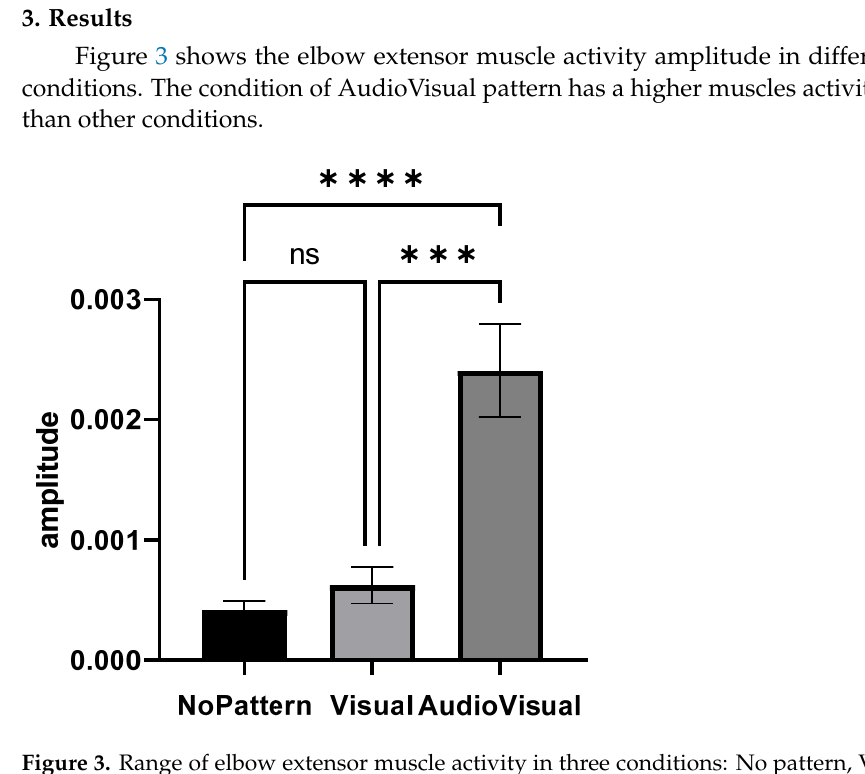
Figure 3. Range of elbow extensor muscle activity in three conditions: No pattern, Visual pattern, and AudioVisual pattern; *** p < 0.001, **** p < 0.0001.